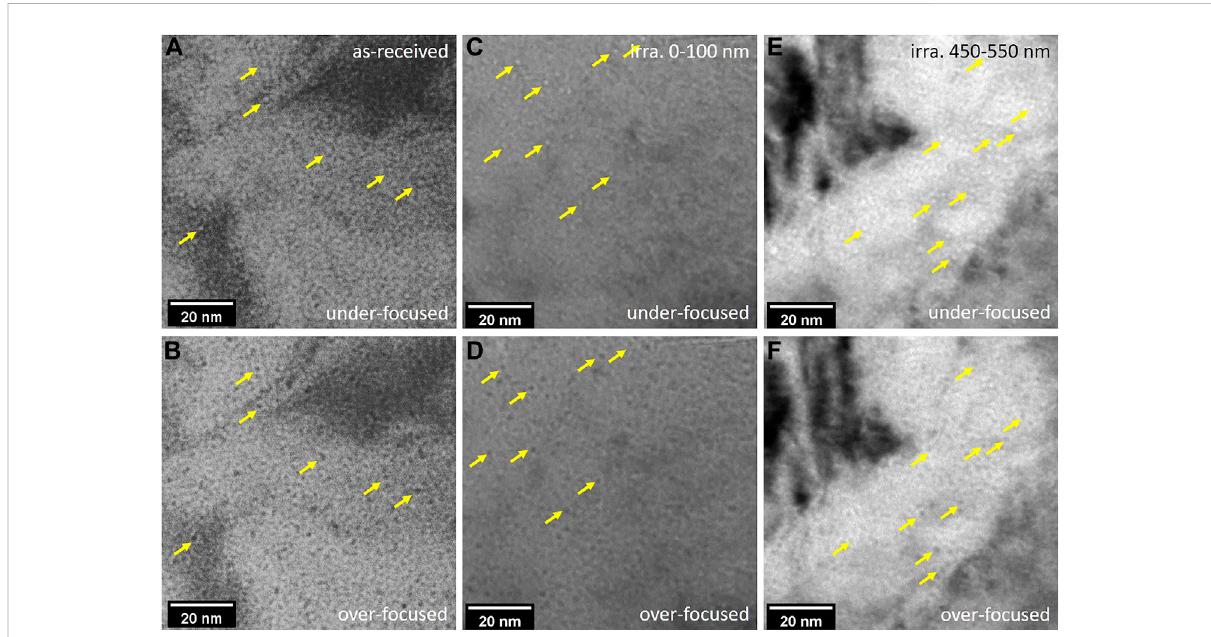
FIGURE 9 Voids in under-focused and over-focused TEM bright fi eld. Some of the voids are illustratedwith arrows. (A,B) Voids in the as-received sample. (C,D) Voids at the near surface area (0 – 100 nm in depth) of irradiated sample. (E,F) Voids in the irradiated sample in depth of 450 – 550